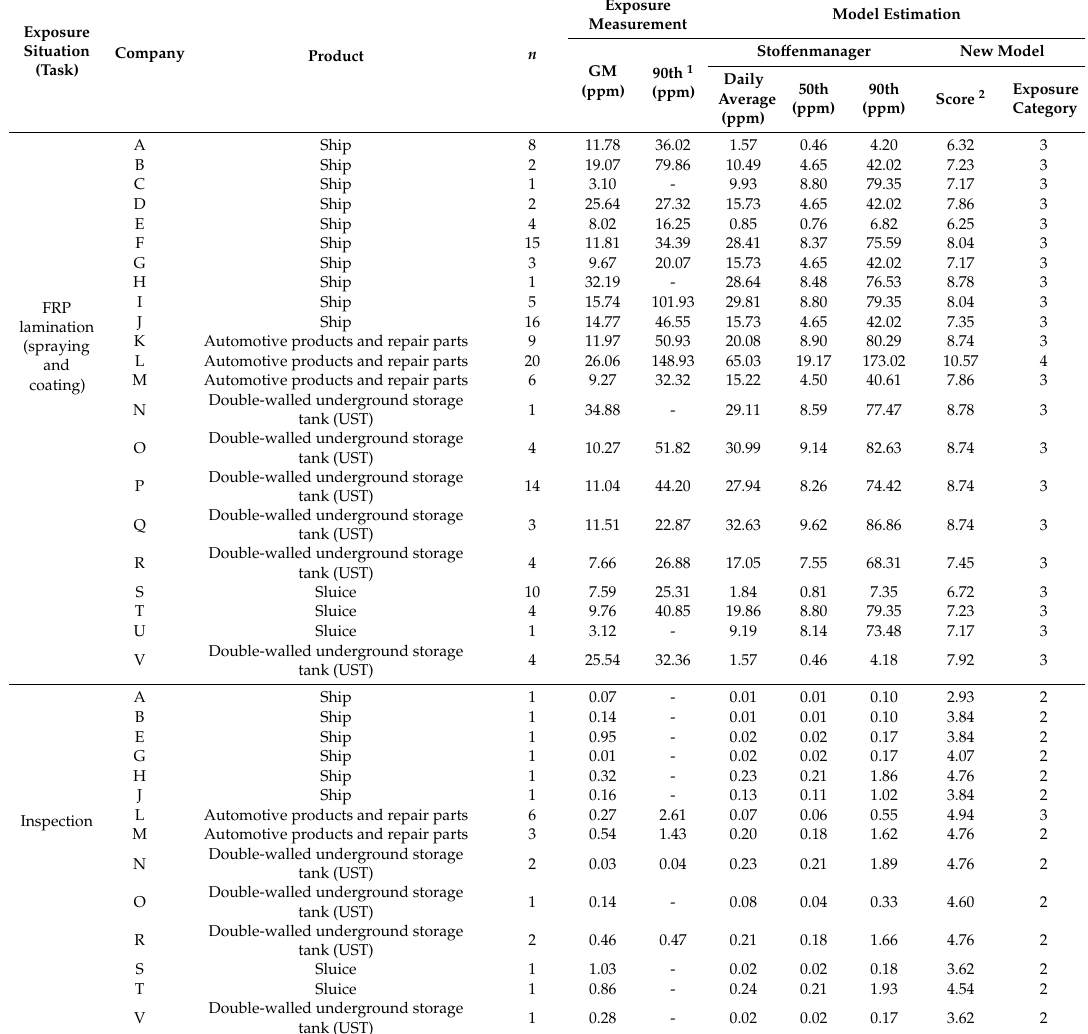
Table5. ComparisonofhistoricalexposuremeasurementswiththemodelestimationsofSto ff enmanager and exposure scores calculated using a new model by